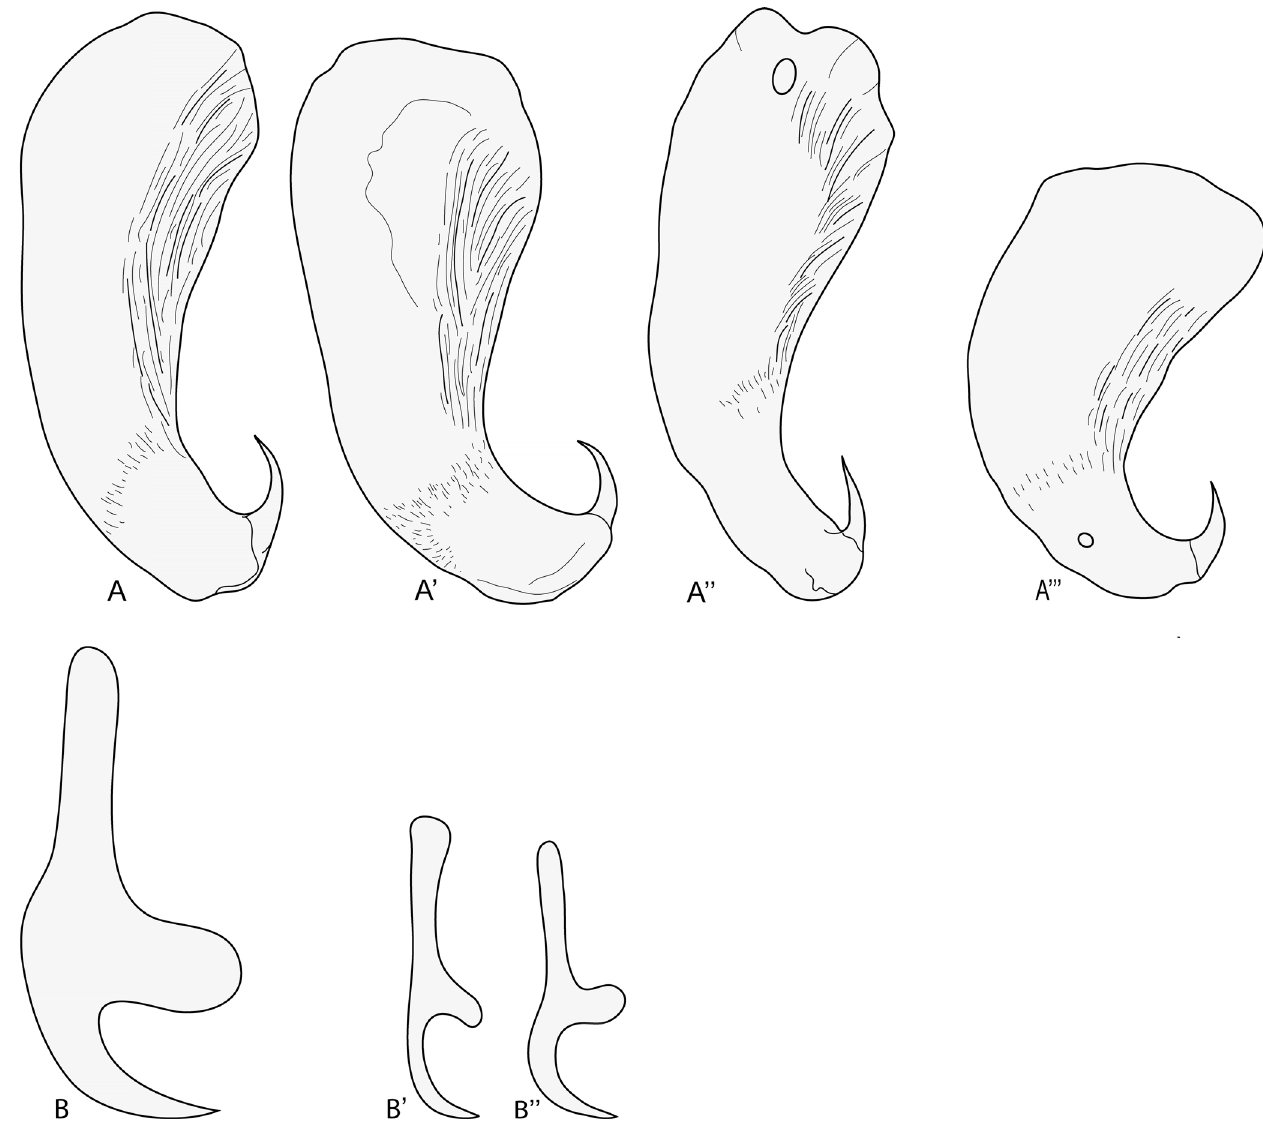
Figure 6. Indopolystoma elongatum n. gen. n. sp. from Zhangixalus arboreus . Hamuli and marginal hooklets from holotype and